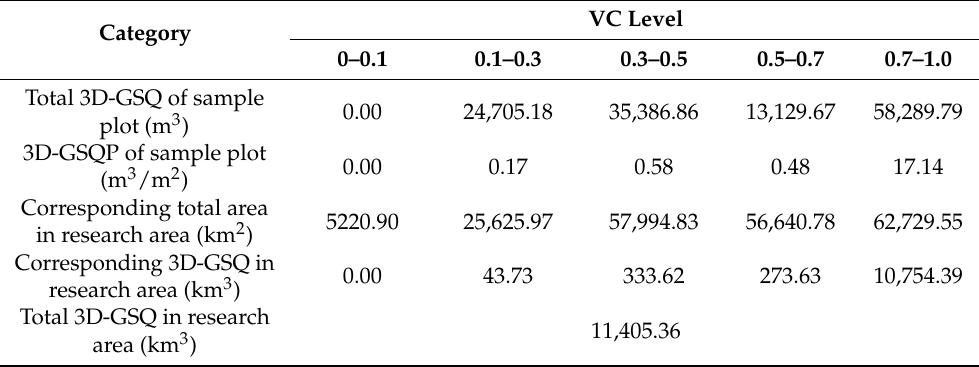
Table 2. The statistics of three-dimensional green space quantity (3D-GSQ) in the urban area of Hohhot.